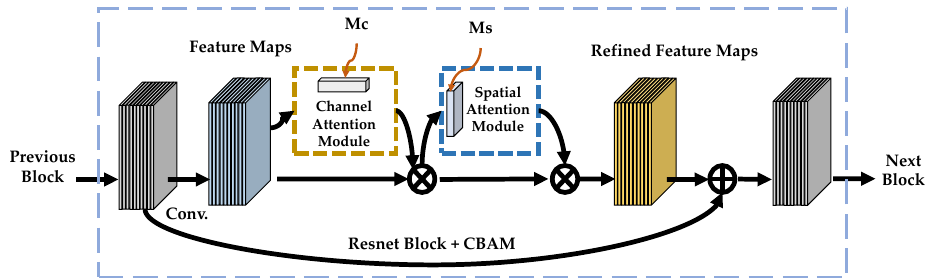
Figure 4. This diagram shows the position where the CBAM module is integrated with the Res- Block [69]. The CBAM is applied to the convolution output of each